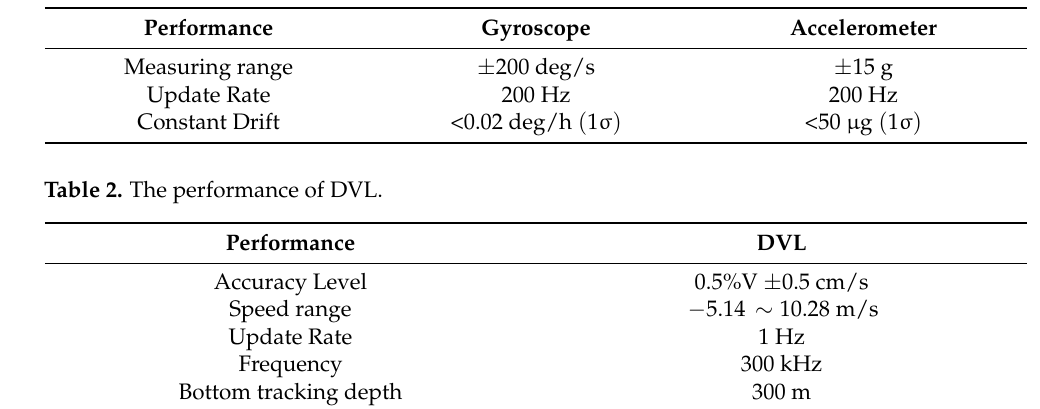
Table 1. The performance of IMU.